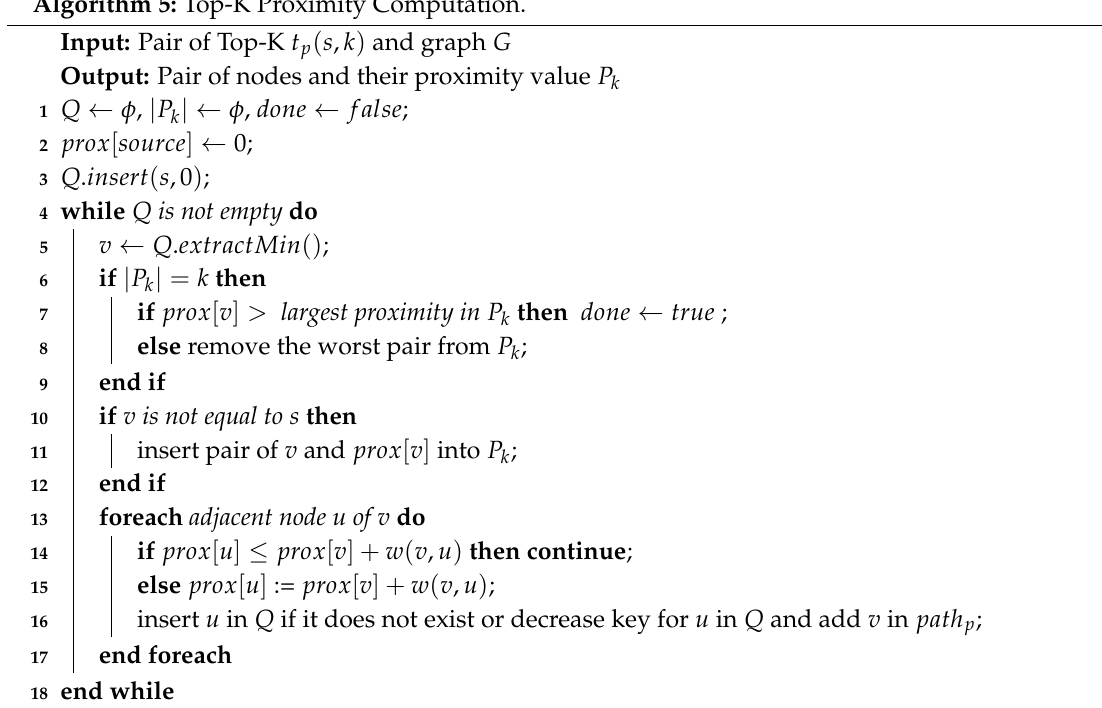
Algorithm 5: Top-K Proximity